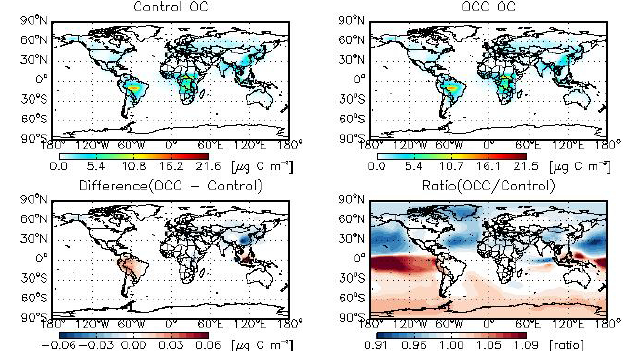
Fig. 5d. Same as Fig. 5b but for zonal mean.